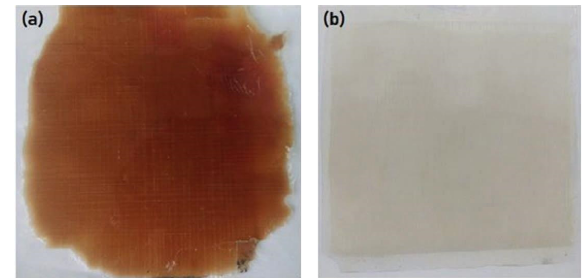
Figure 2: Composite samples prepared of a single layer oriented in biaxial direction: (a) silk fbres and (b) silk cloth.